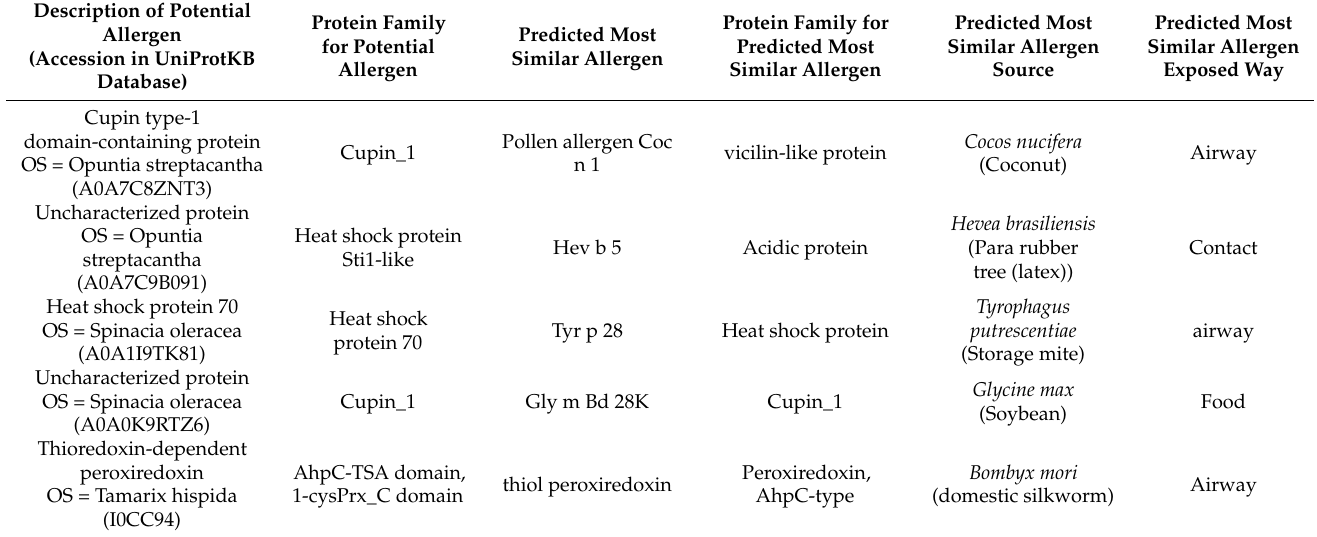
Table 4. Potential allergens from red-fleshed pitaya seeds predicted using three online platforms for protein